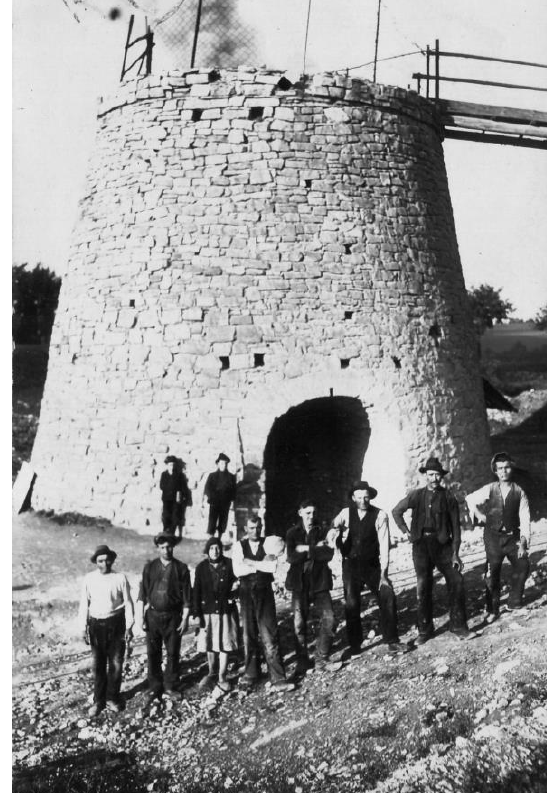
Fig. 4. Workers in front of a lime kiln in Mokre – first half of the 20th century (Source: https://polska- org.pl/8505977,foto.html?idEntity=8505979)